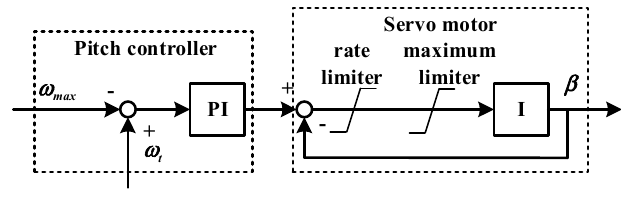
Figure 3. Pitch controller scheme.